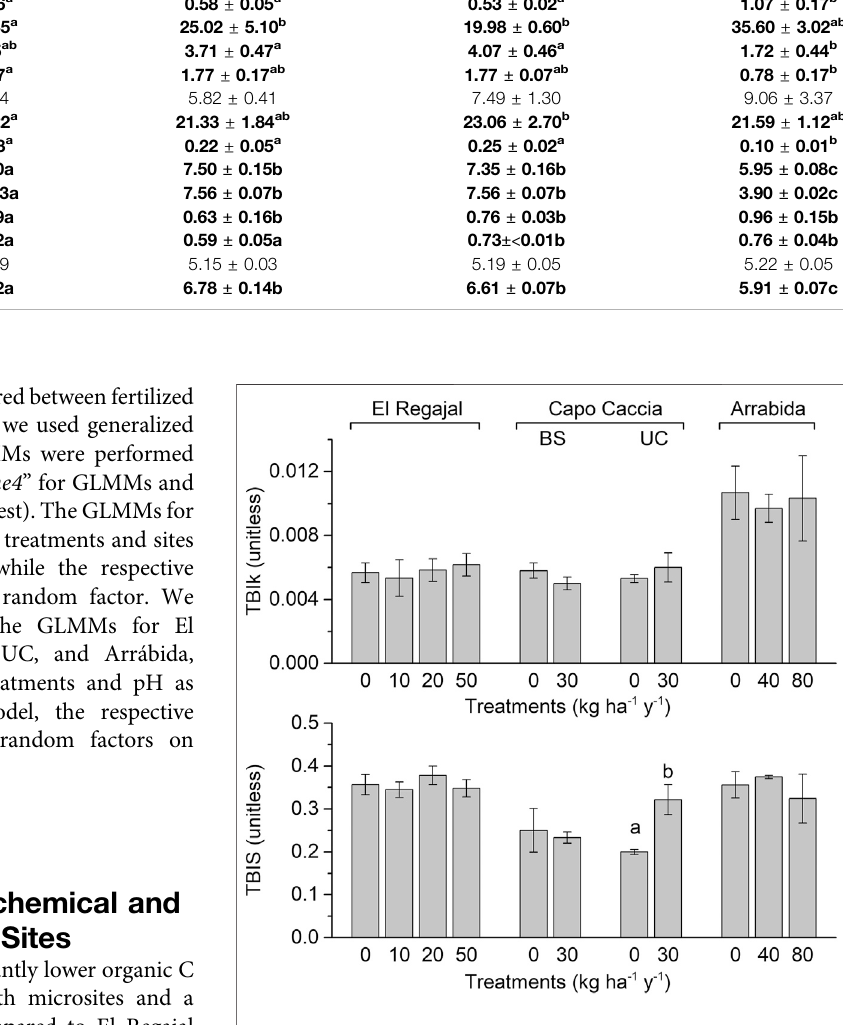
FIGURE 1 | Effect of nitrogen (N) addition on soil decomposition rate (TBIk) and stabilisation factor (TBIS) (means ± SE) in the top 8 cm of the soil pro fi le estimated through the tea bag index method for each N treatment in El Regajal (Spain, n (cid:2) 6), Capo Caccia BS (Italy, n (cid:2) 4), Capo Caccia UC (Italy, n (cid:2) 4) and Arrábida (Portugal, n (cid:2) 3). Capo Caccia BS and UC indicate bare soil and under canopy microsites, respectively. Tea bags incubations were performed for 65 days in spring 2014. Letters indicate signi fi cant differences among N treatments within each site ( p < 0.05, one-way ANOVA, post hoc LSD